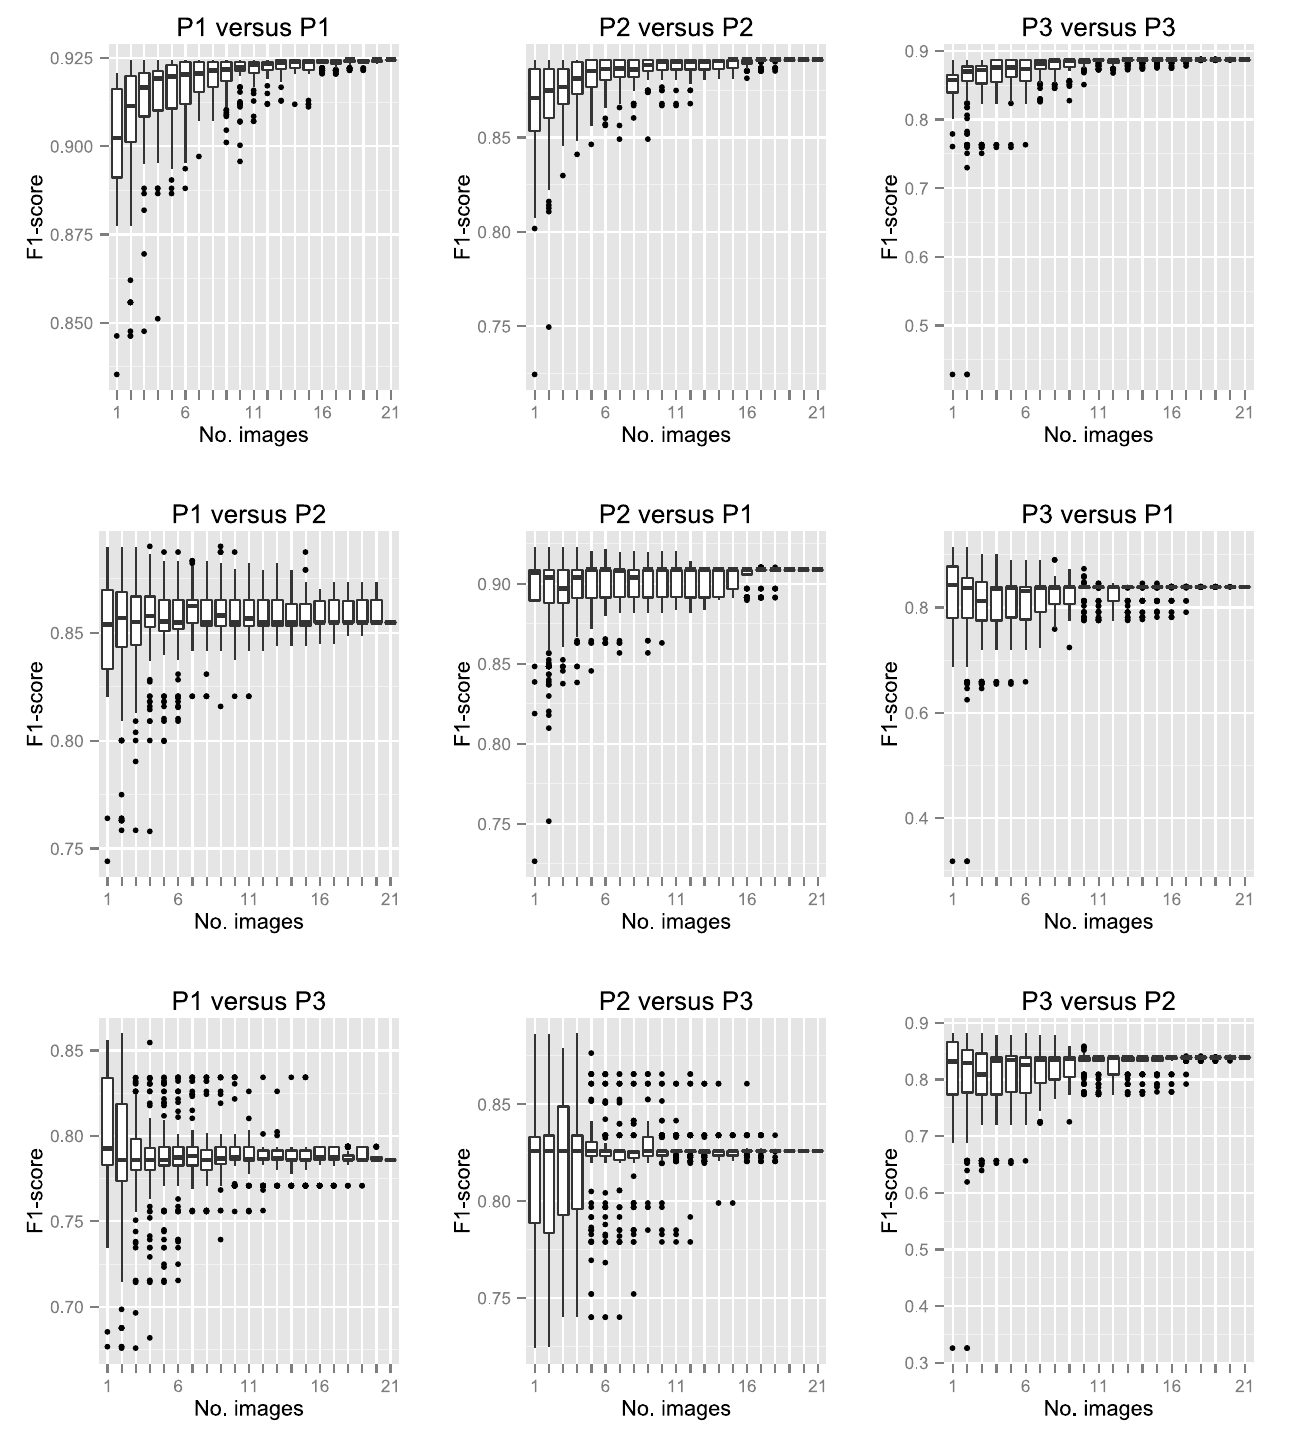
Figure 8. Training on multiple images improves consistency in focus detection. The FindFoci Optimiser was trained using 1 to 21 images. When the number of combinations of images used for training was small (n 5 1 or n 5 20 has 21 possible combinations; n 5 2 or n 5 19 has 210 possible combination) all possible combinations were used. For larger numbers of possible combinations, a random subset of 100 combinations were used to select images for training of the algorithm. The parameters obtained from training were tested against the manually marked images from each experimenter and the F1-score calculated. P1 to P3 refers to experimenter ID, with the first mention indicating the images used for training and the second referring to the